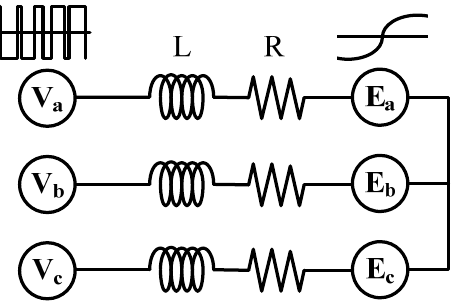
Figure 4. The model of the inverter with the